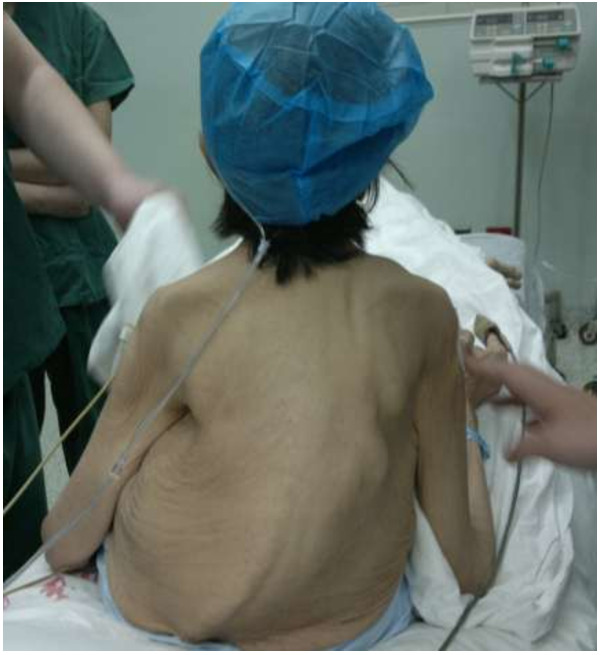
Bone deformities.